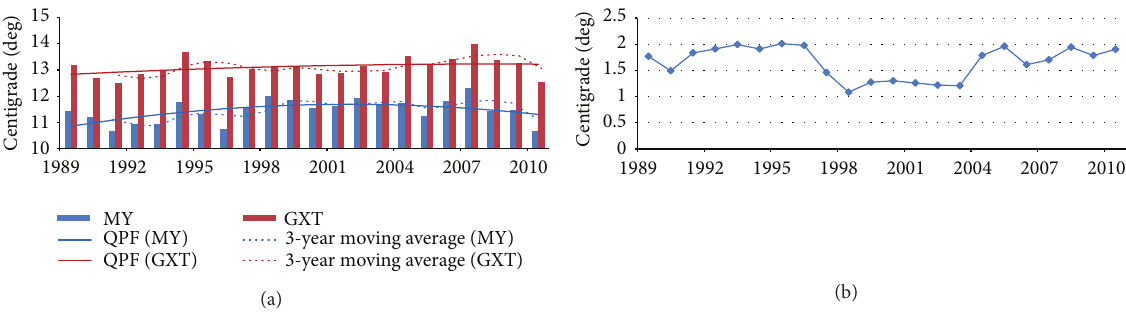
Figure 4: The annual mean temperature, Quadratic Polynomial Fitting (QPF), and a 3-year moving average of Guan Xiang Tai (GXT) and Mi Yun (MY) (a) and temperature differences (b) between the two stations in the period of